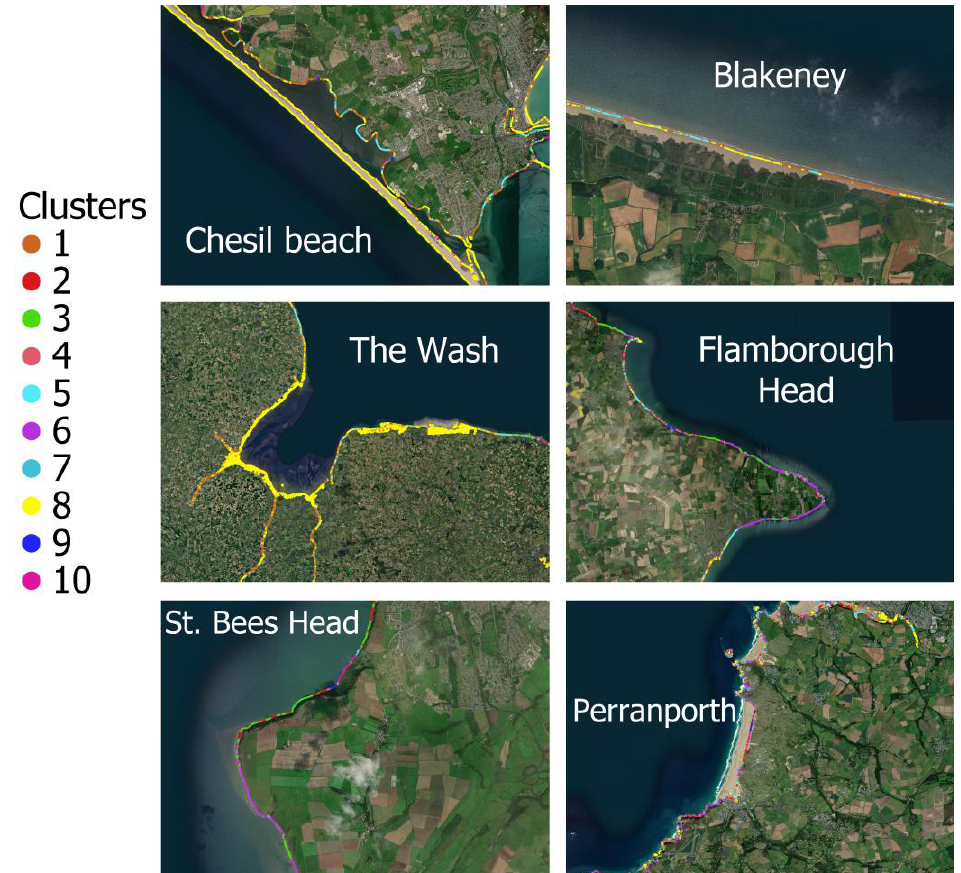
Figure 11. Cluster types mapped to the coast point along the high water mark line used to delineate the transects. Names of the locations around the GB coastline indicated as text. Source of aerial imagery: Esri, Maxar, GeoEye, Earthstar Geographics, CNES / Airbus DS, USDA, USGS, AeroGRID, IGN, and the GIS User Community, v10.6.